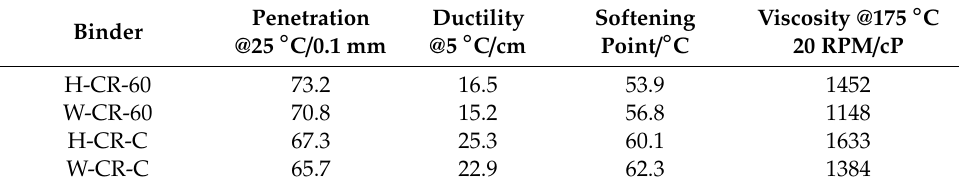
Table A1. Conventional properties of crumb rubber modified asphalt binder.